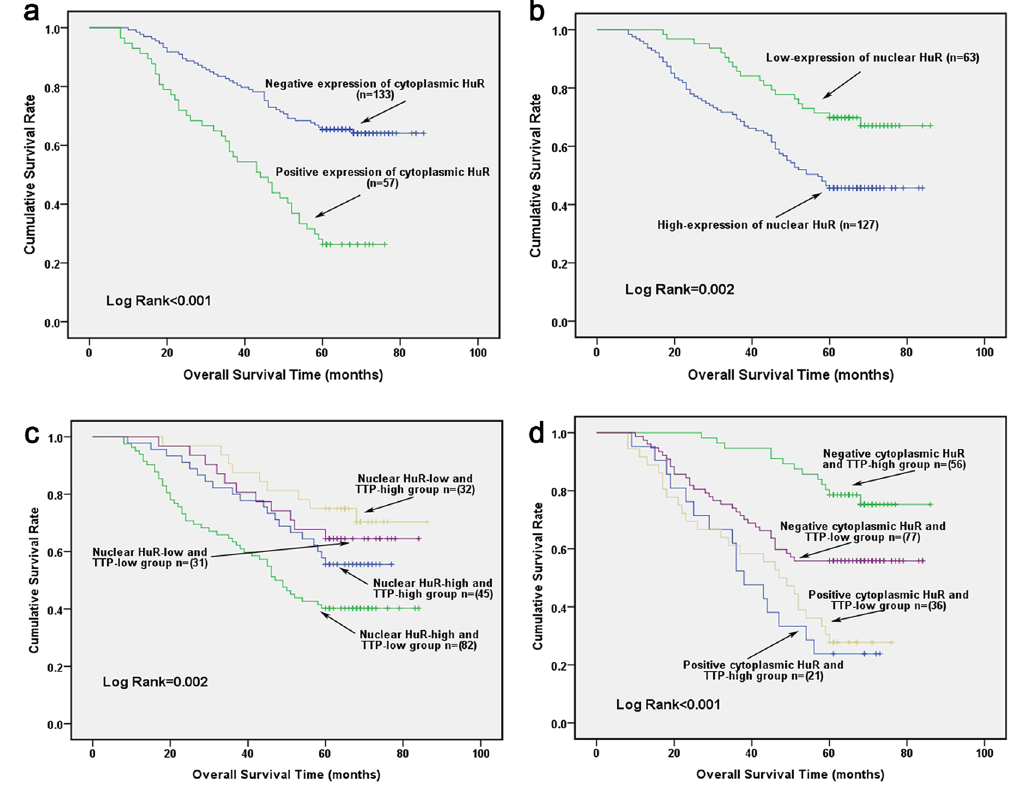
Figure 6. High HuR nuclear expression and aberrant cytoplasmic distribution were associated with poor survival in GC patients. Kaplan-Meier analysis was used to analyze the survival rate in ( a ) different cytoplasmic HuR expression; ( b ) different nuclear HuR expression groups; ( c ) different combinations of nuclear HuR and TTP expression groups; ( d ) different combinations of cytoplasmic HuR and TTP expression